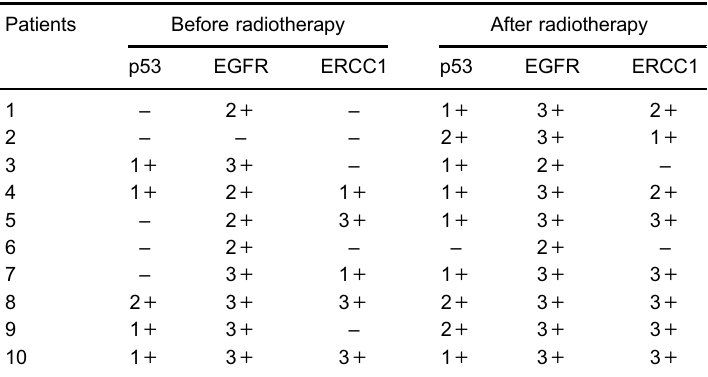
Table 1. Scoring of p53, EGFR and ERCC1 immunohistochemistry in malignant tissues from cervical cancer patients.